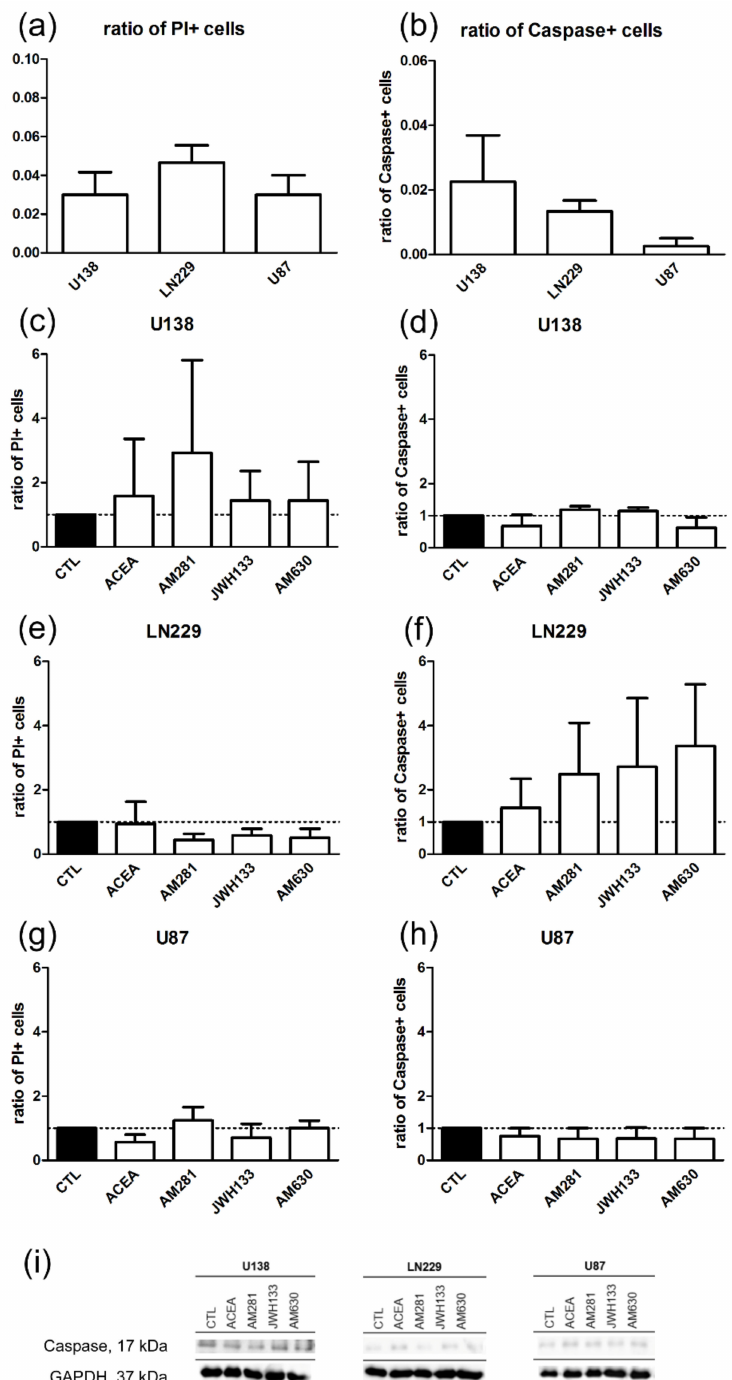
Figure 3. No changes in the ratio of death cells could be observed in U-138 MG, LN229, and U-87 MG cell lines after treatment with agonists (ACEA, 10 µ M; JWH133, 10 µ M) and antagonists (AM281, 1 µ M; AM630, 1 µ M) for CB 1 and CB 2 . Differences between the cell lines in the basal level of cell death markers were not significant. Control groups of U-138 MG, LN229 and U-87 MG cell lines were compared in the ratio of positive cells for ( a ) propidium iodide (PI) ( n U138 = 3, n LN229 = 3, n U87 = 3) and ( b ) caspase ( n U138 = 4, n LN229 = 3, n U87 = 4). Application of ACEA, AM281, JWH133 and AM630 did not influence the ratio of PI or caspase positive cells in ( c ), ( d ) U-138 MG ( n CTL = 3, n ACEA = 3, n AM281 = 3, n JWH133 = 3, n AM630 = 3); ( e ), ( f ) LN229 ( n CTL = 3, n ACEA = 3, n AM281 = 3, n JWH133 = 3, n AM630 = 3) and ( g ), (h) U-87 MG cells ( n CTL = 3, n ACEA = 3, n AM281 = 3, n JWH133 = 3, n AM630 = 3). ( i ) Representative Western Blots of caspase and GAPDH show no significant differences between the groups. All data were normalized to control